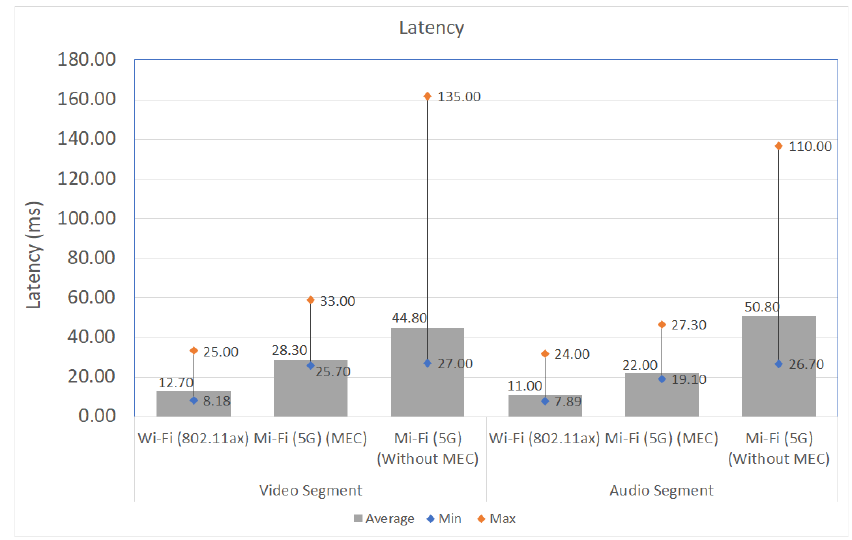
Figure 9. Multi-Access Edge Network Packet Loss Rate.